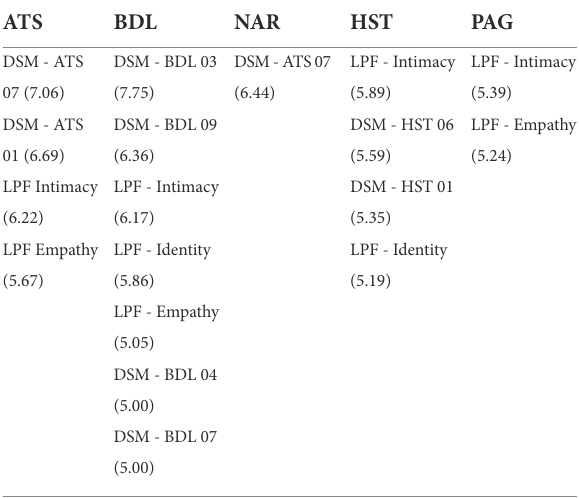
TABLE 7 Symptoms having a positive likelihood ratio (given in parenthesis) higher or equal than 5 for some personality disorder. ATS